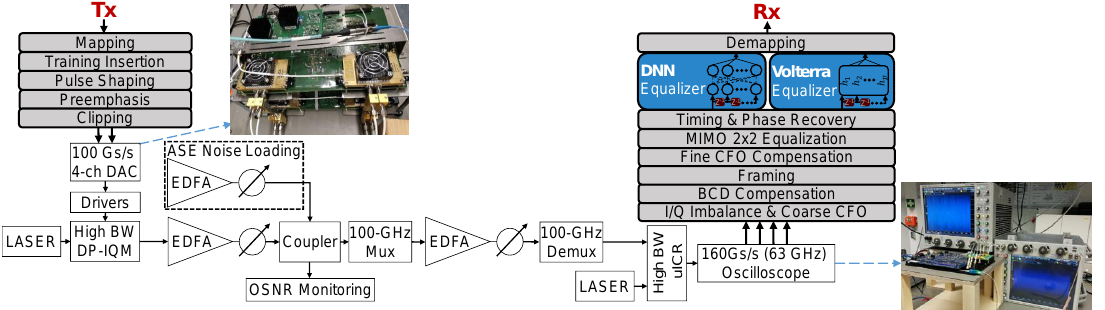
Figure 4. Back-to-back offline measurement setup including Tx and Rx digital signal processing (DSP) with different methods to compute the